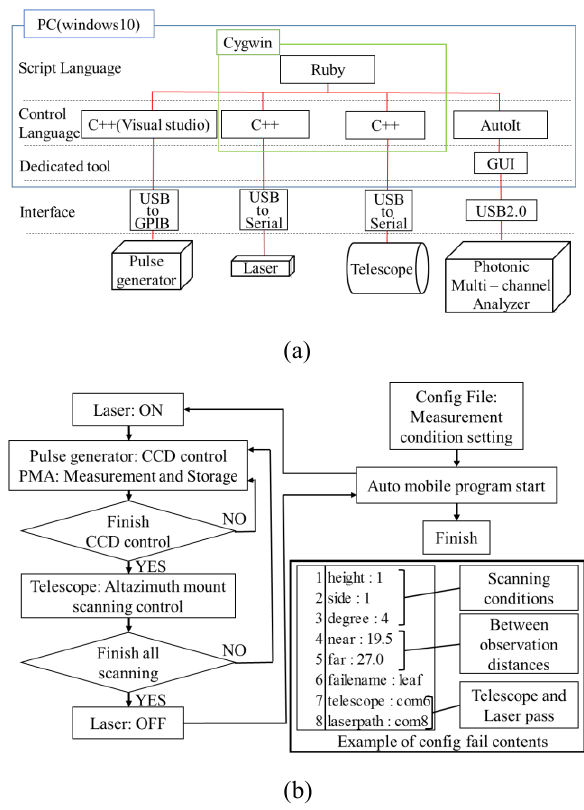
Fig. 3 Structure of the LIFS lidar software (a) and flow chart (b). a horizontal angle resolution of 1 degree x 13m (vertical distance, V) with a vertical angle resolution of 1